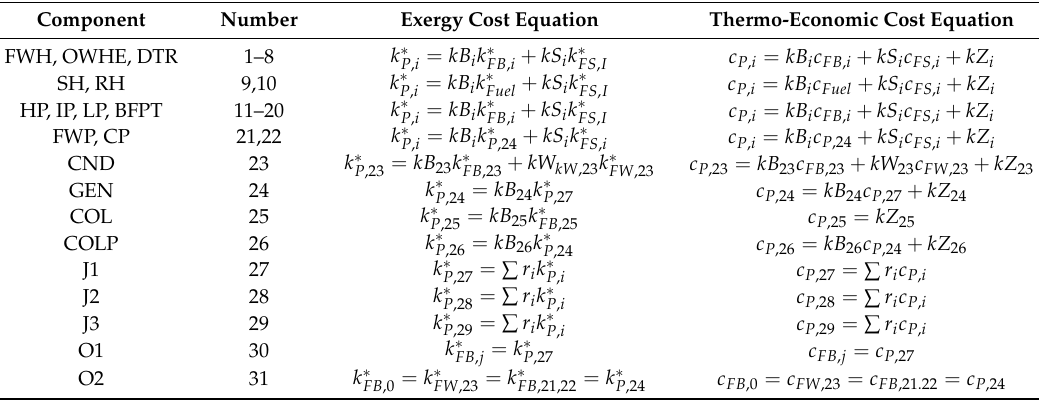
Table 1. Exergy cost equation and thermo-economic cost equation.